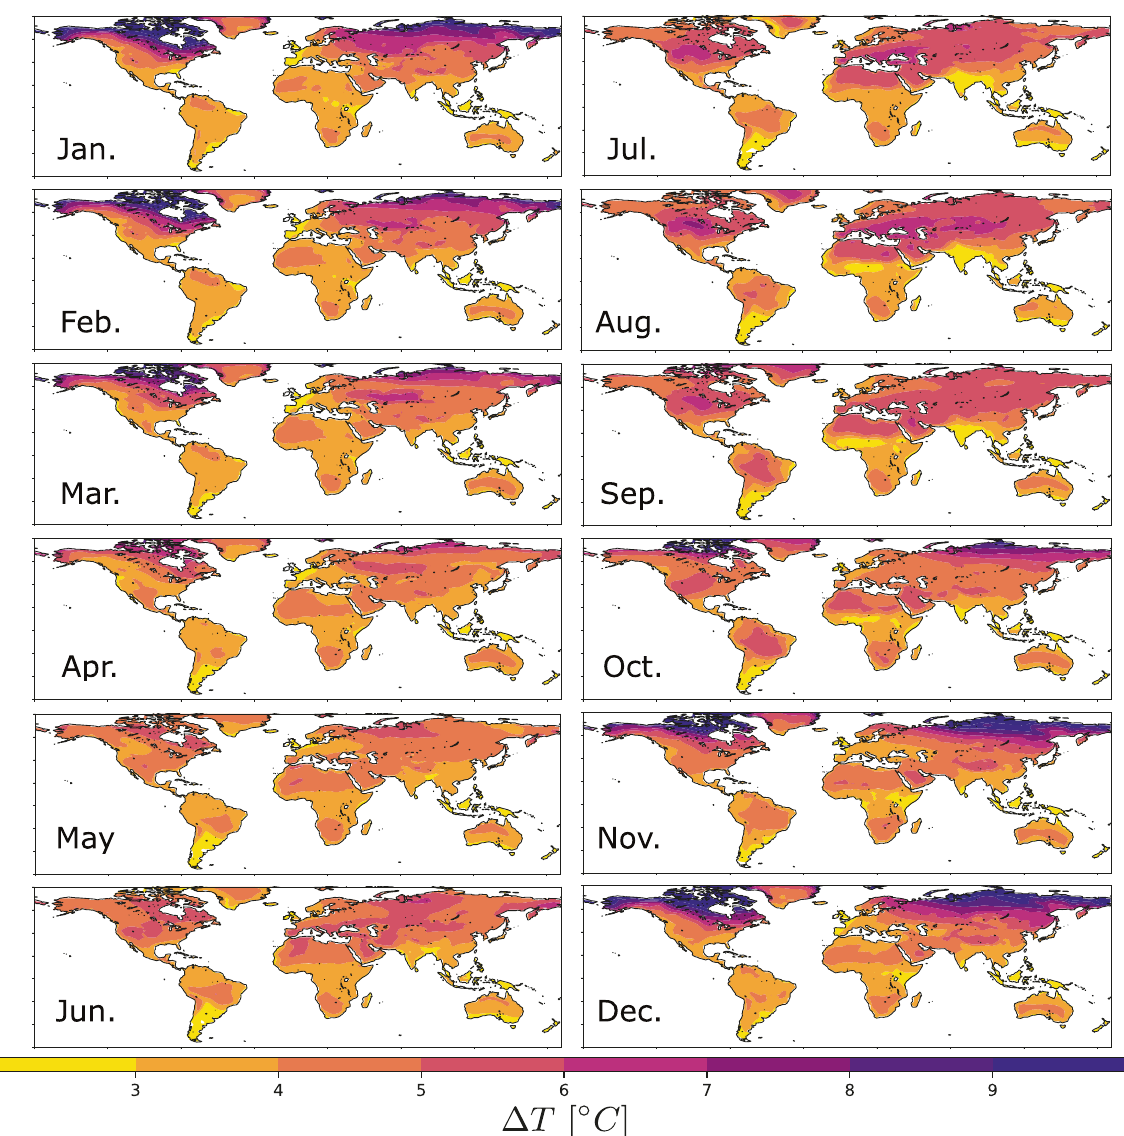
Fig. 2 Local temperature change across months. Mean temperature change in each calendar month from the 50th percentile 2100 warming scenario (global mean temperature change of